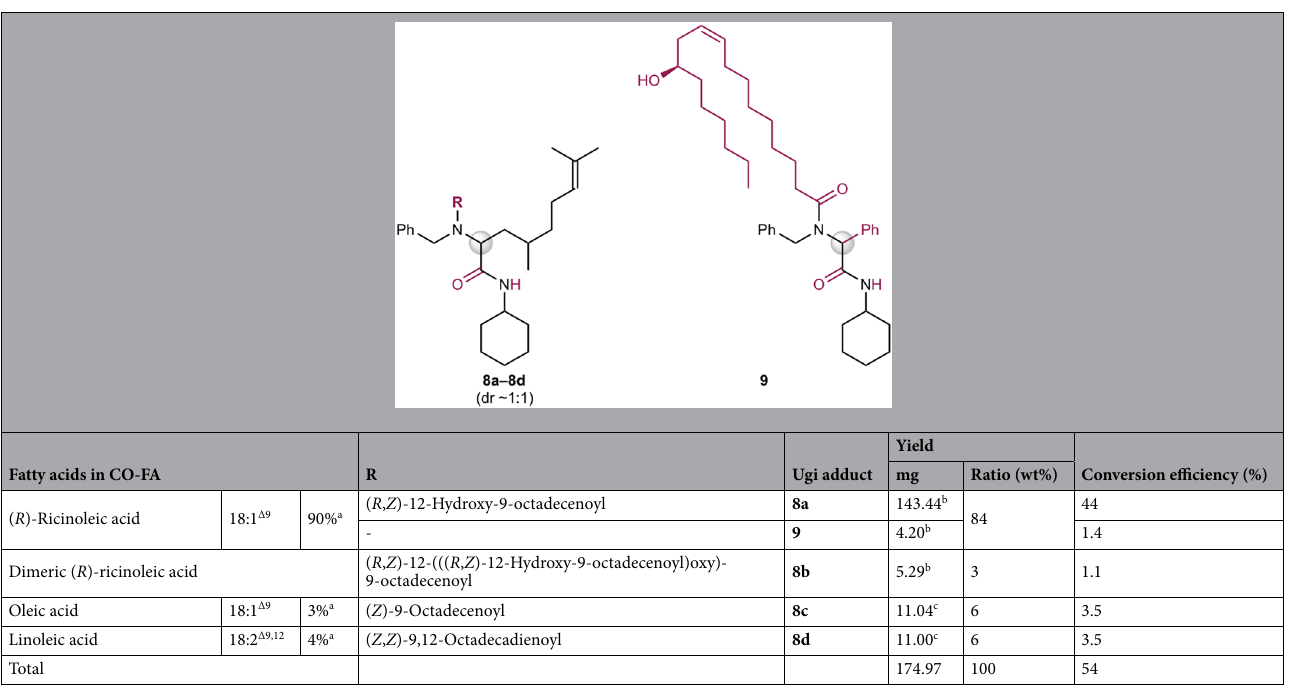
Table 2. Ugi adducts 8a – 8d and 9 derived from CO-FA. a Data (wt%) from Ref. 33 . b Isolated yield. c Estimated yield from 1 H NMR analysis of a mixture of 8c and 8d